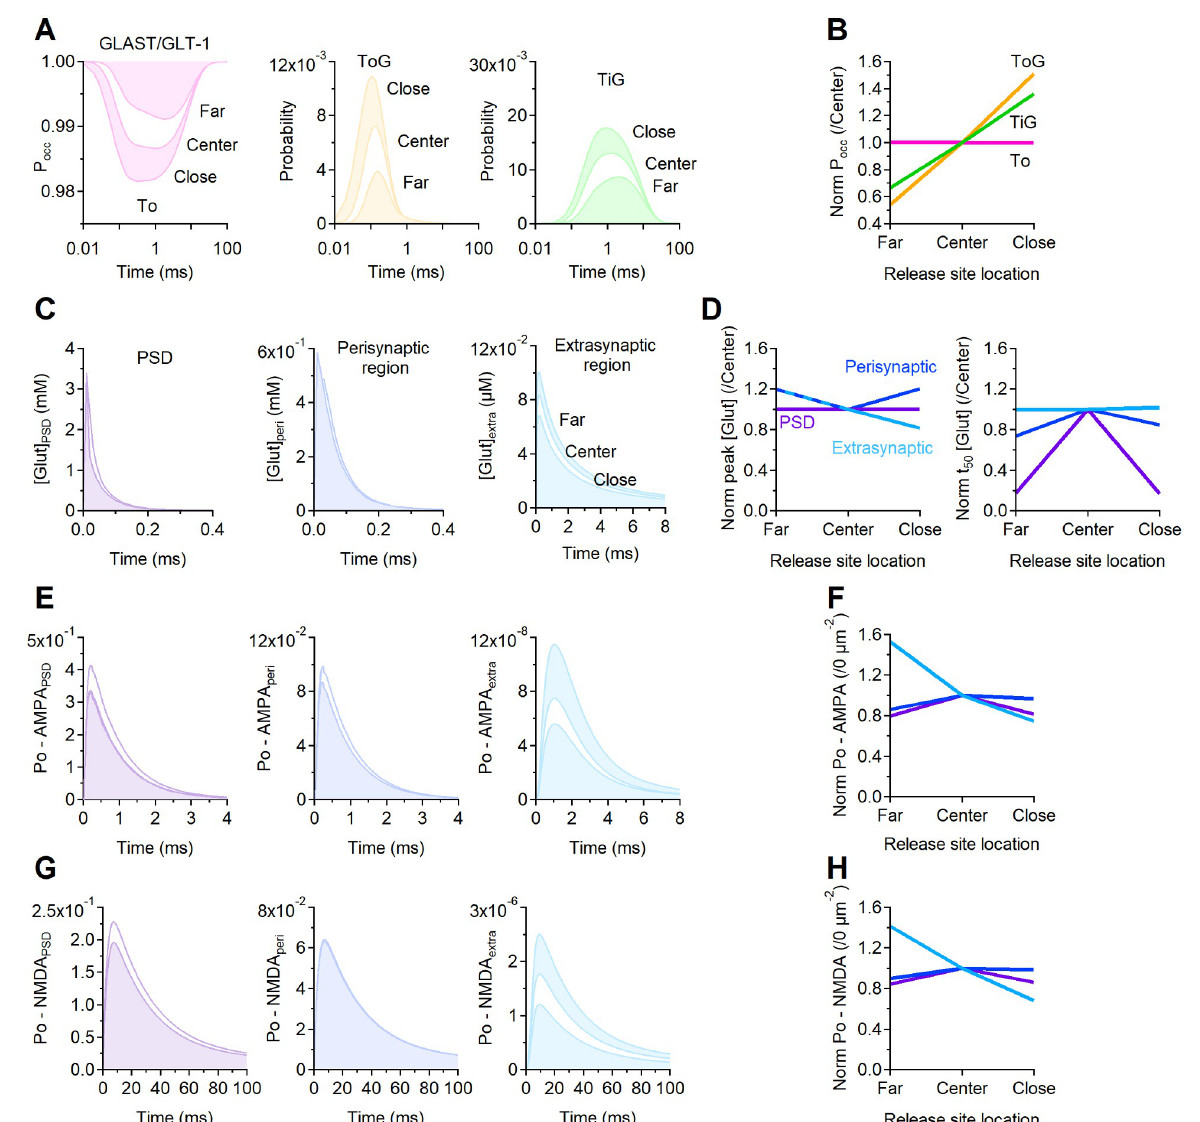
Fig 8. Changing the location of the release site for σ astro = 20,000 μm − 2 . A . The three graphs in this panel provide a description of the probability for each transporter of being in one of the three states To , ToG or TiG , with σ = 20,000 μm − 2 , when the release site is located above the center of astro the PSD, close or far from the glial sheet (Fig 6A). B . Summary describing how the probability of glutamate transporters of being in one of the three states To , ToG or TiG varies with release site location. The data are normalized based on the results obtained when the release site is located above the center of the PSD. C . Temporal profile of the glutamate concentration in the PSD ( left ), perisynaptic ( center ) and extrasynaptic regions ( right ), for different release site locations. D . Summary of the peak and half decay time ( t 50 ) of the glutamate concentration measured in the PSD ( purple ) and perisynaptic regions ( blue ), and in the extrasynaptic region ( cyan ). The data are normalized based on the results obtained with the release site located above the center of the PSD region. E . Open probability of synaptic ( left ), perisynaptic ( center ), and extrasynaptic AMPA receptors ( right ) measured for different release site locations. F . Summary of the peak open probability of AMPA receptors. The data are normalized based on the results obtained with σ astro = 0 μm − 2 . G,H . As in E,F, for NMDA receptors. Lines are used in panels B, D, F, H to facilitate the interpreration of the results, collected using three different release site locations. Data represent mean values.